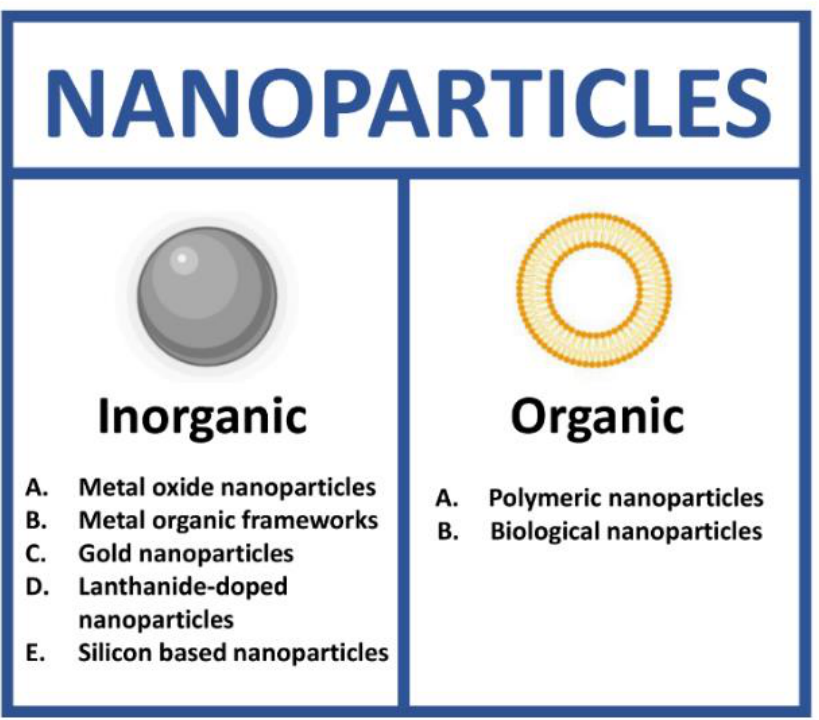
Figure 2. Types of nanoparticles for theranostics. (Created with BioRender.com, accessed on 17 July 2022).